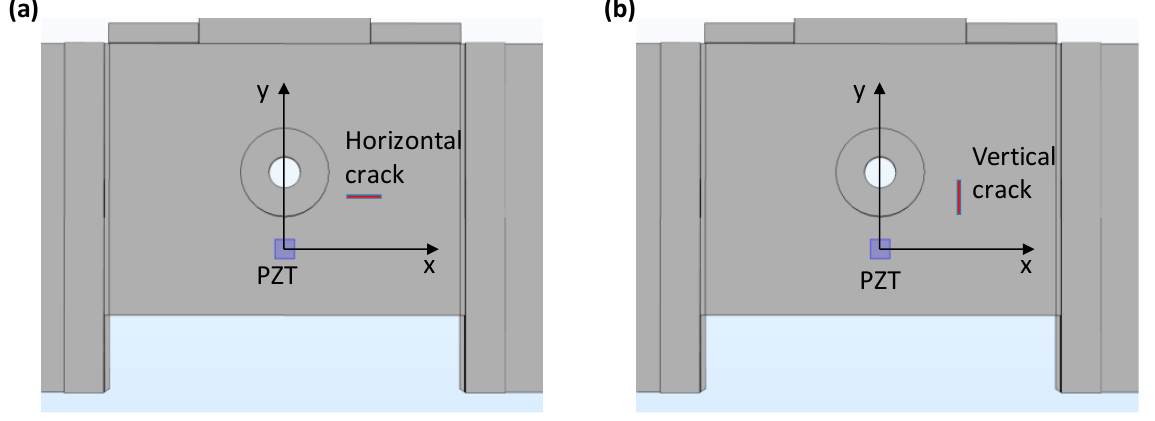
Figure 6. Simulation of cracks in the bearing plate: ( a ) Horizontal crack; ( b ) vertical crack.